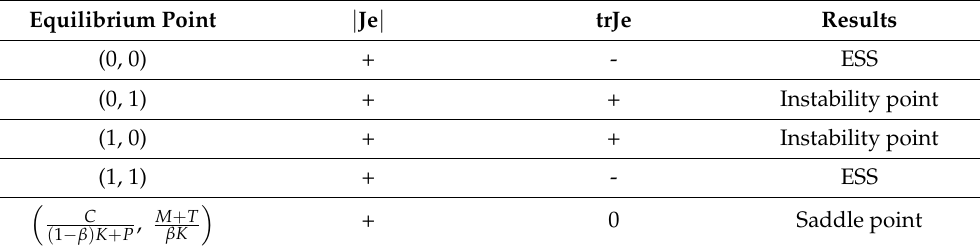
Table 3. Equilibrium results when the benefits received by residents and the government are both greater than the costs paid by them.